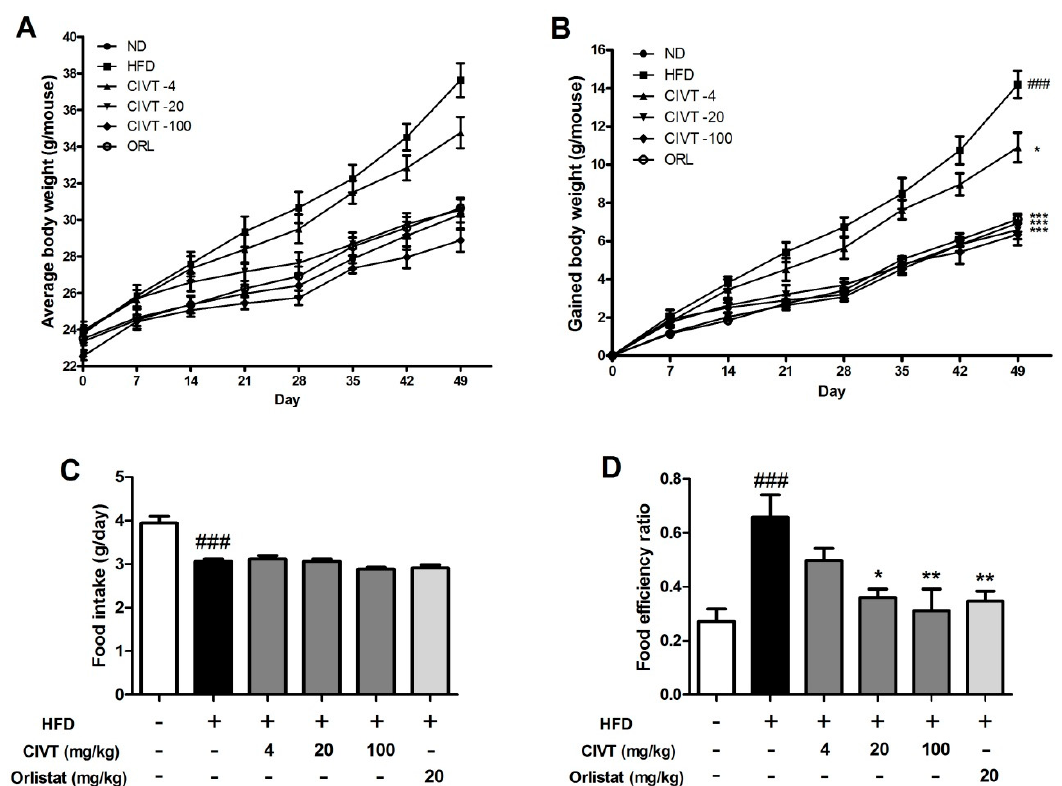
Figure 1. Effects of CIVT on body weight gain, food intake and food efficiency ratio in HFD-fed obese mice. The mice ( n = 6) were fed normal chow diet (ND) or high-fat diet (HFD). HFD fed mice were administered CIVT (4, 20 or 100 mg/kg) or orlistat (20 mg/kg) orally once a day. During the 7-week experimental period, average body weight ( A ), gained body weight ( B ), food intake (g per day) ( C ) and food efficiency ratio ( D ) was measured once a week. Food efficiency ratio = Gained body weight (g)/Food intake during trial period (g). Values represent the means ± SEMs ( n = 6). Data were analysed by Bonferroni correction for post-hoc test. ### p < 0.001 versus the ND group; * p < 0.05, ** p < 0.01 and *** p < 0.001 versus the HFD group.